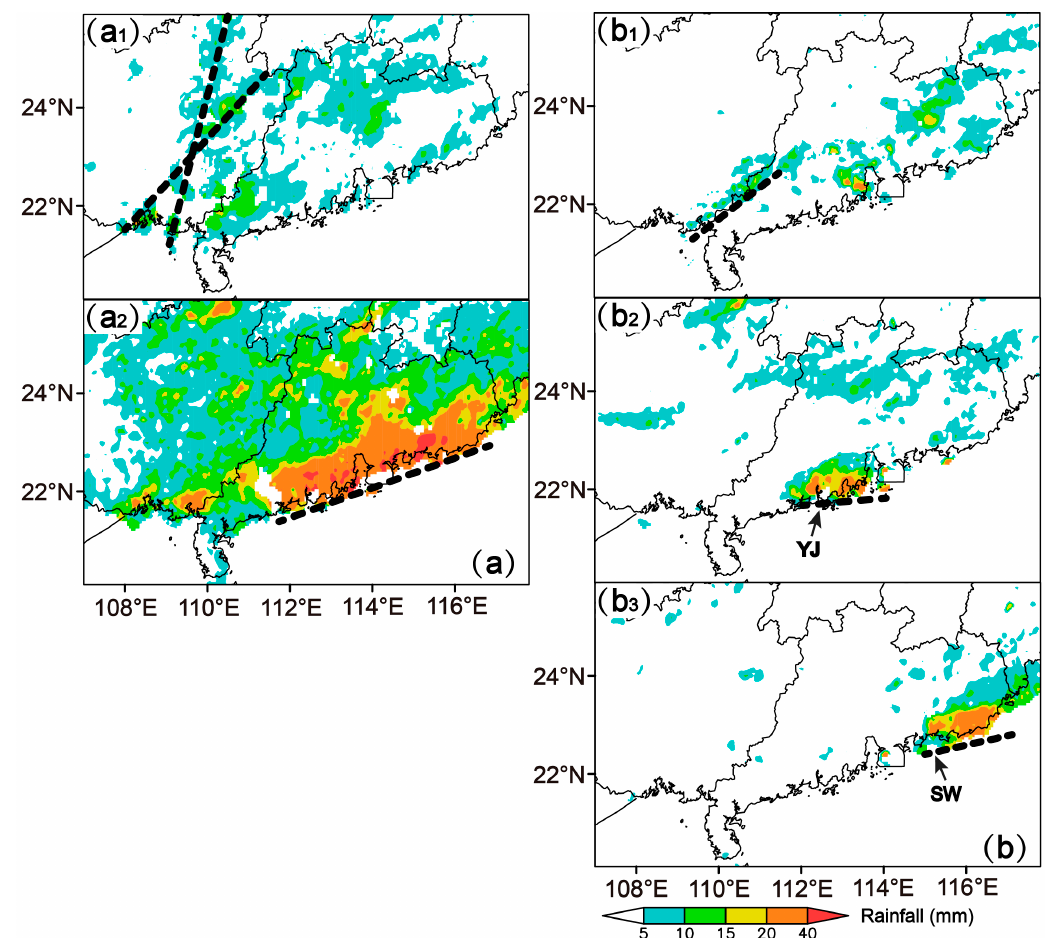
Figure 3. Composite distributions of OWSR (color-shaded; units: mm) over South China with ( a , a 1 – a 2 ) a long and ( b , b 1 – b 3 ) a short extension. ( a 1 ) and ( a 2 ) indicate the OWSRs located near the coastal areas of Guangxi Province and Guangdong Province, respectively, and ( b 1 , b 2 , b 3 ) indicate the OWSRs located at the boundary area between Guangxi and Guangdong provinces, west Guangdong Province and east Guangdong Province, respectively. The composite distributions for ( a 1 ), ( a 2 ), ( b 1 ), ( b 2 ), and ( b 3 ) are drawn from 31, 20, 6, 18, and 17 events, respectively. The dashed lines outline the primary orientations of OWSRs, and “YJ” and “SW” indicate Yangjiang city and Shanwei city.